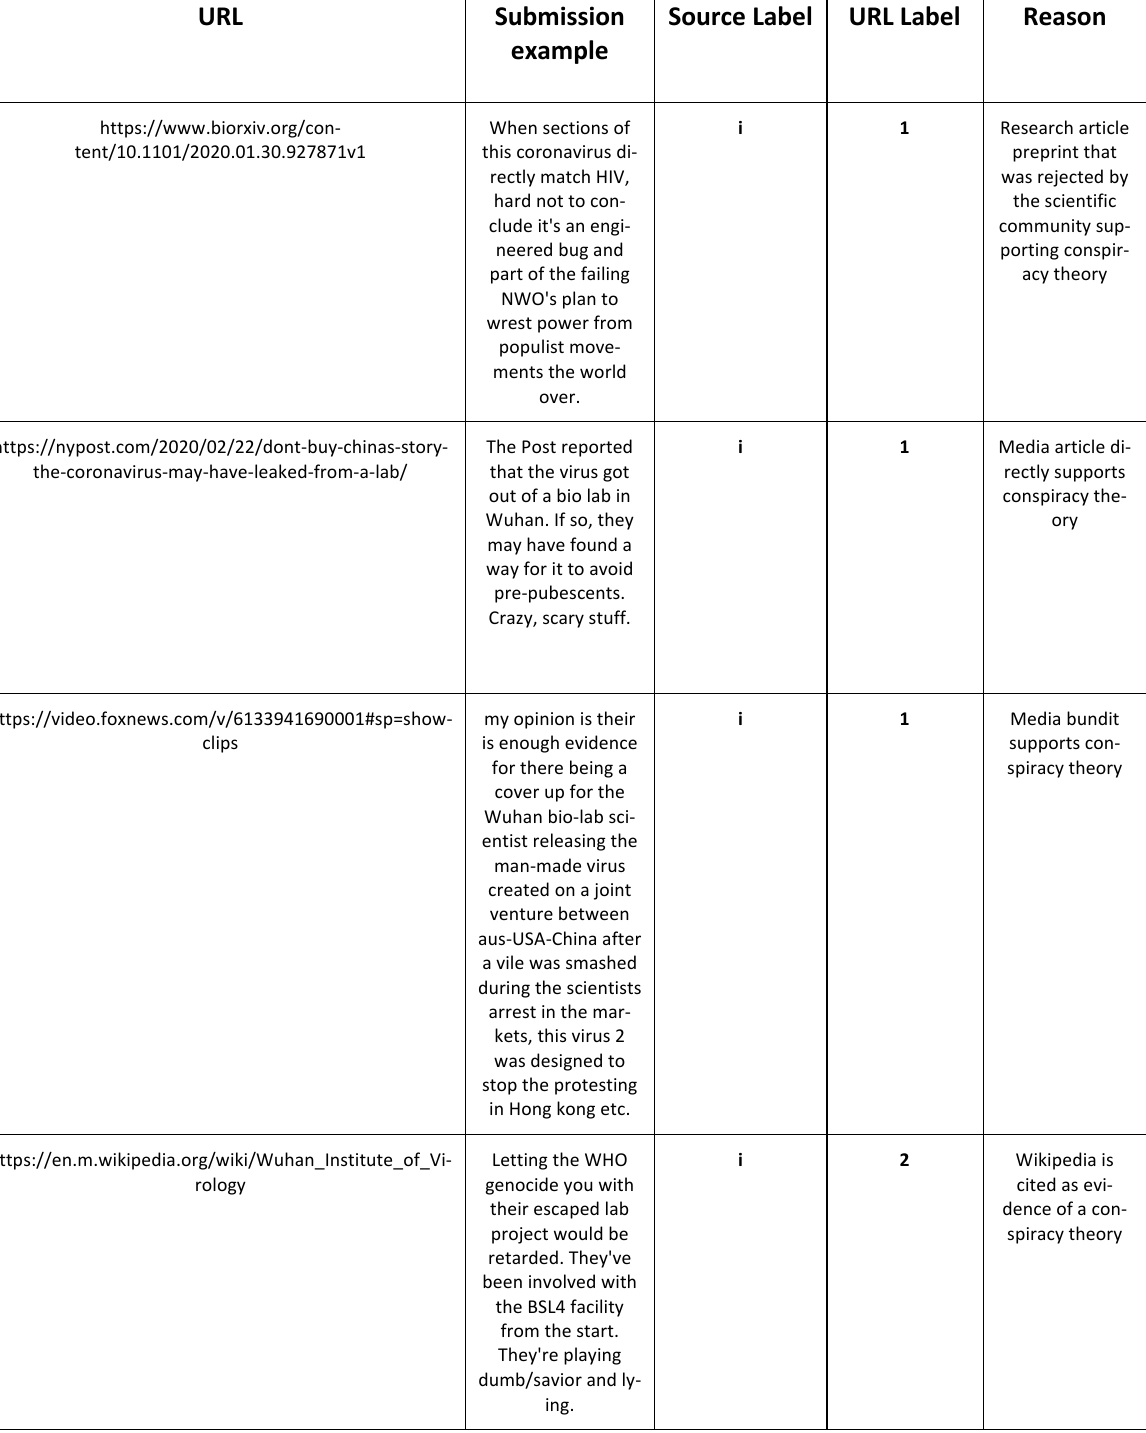
Table 5. Exemplary URLs from our dataset. The table includes the assigned source label, URL label, and the reason behind that decision. It also provides an exemplary social media submission that the URL